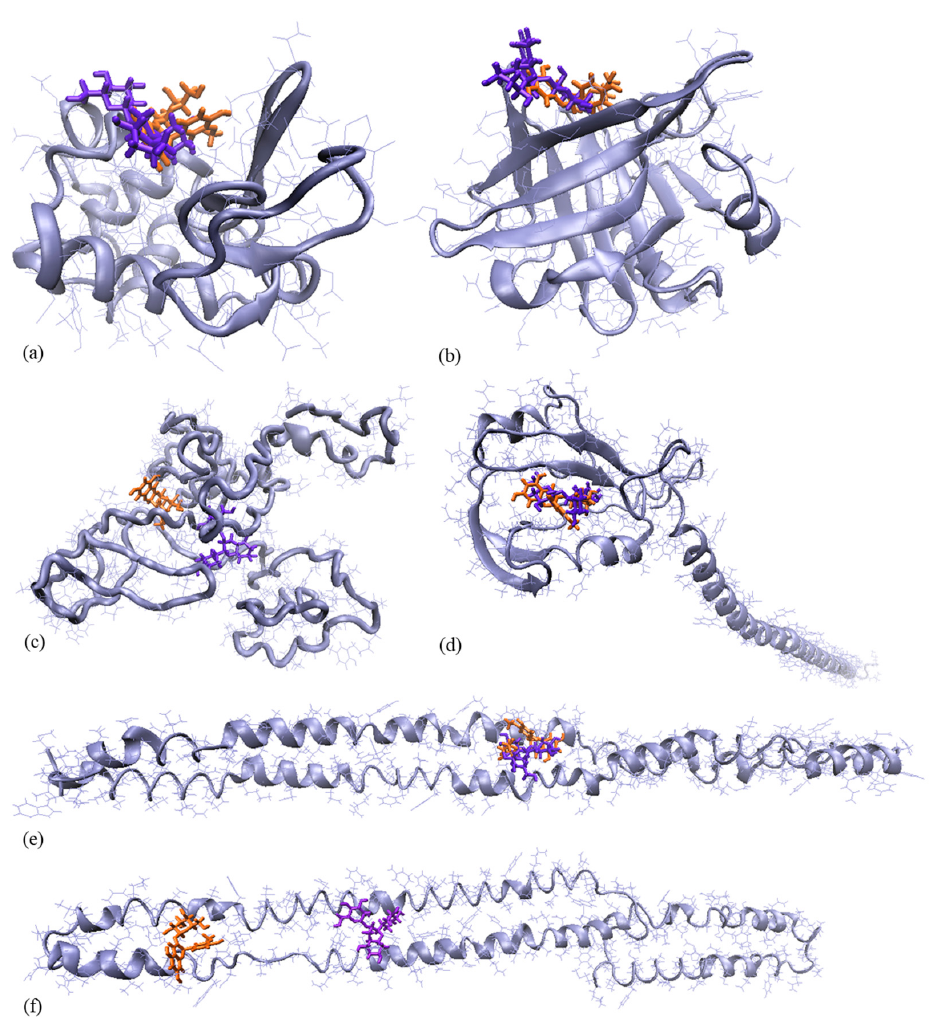
Figure 1. Single molecule level details on binding of cyanidin-3- O -glucoside (violet) and peonidin-3- O -glucoside (orange to the α -LA ( a ), β -LG ( b ), β CN ( c ), kCN ( d ), α S1CN ( e ), and α S2CN ( f ). Images were prepared using VMD software. The proteins are represented with ice blue in new cartoon style, while anthocyanins are represented in licorice style.